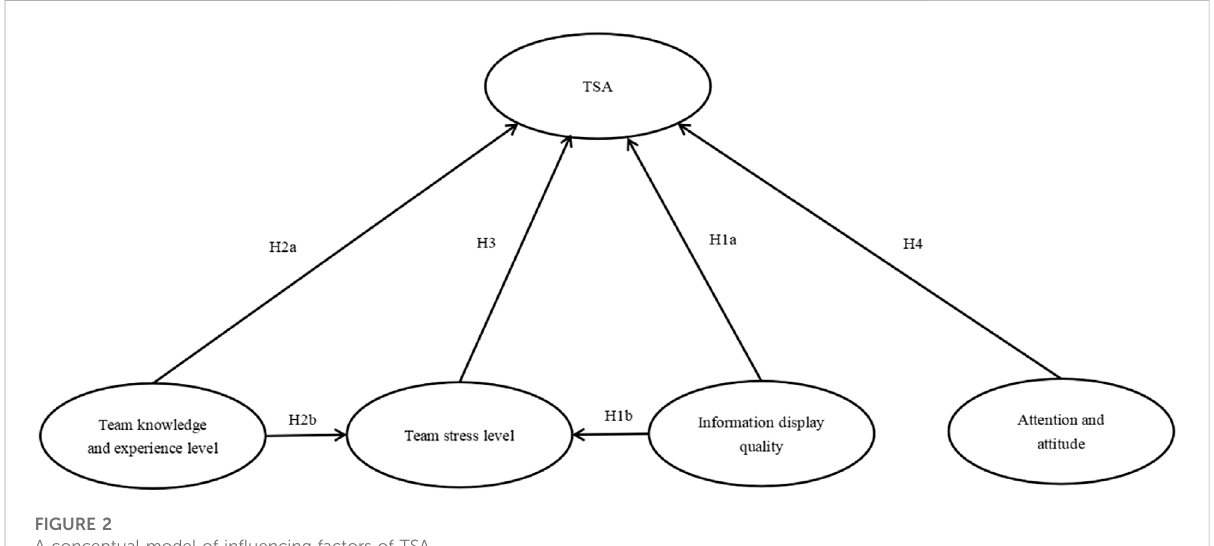
FIGURE 2 A conceptual model of in fl uencing factors of TSA.